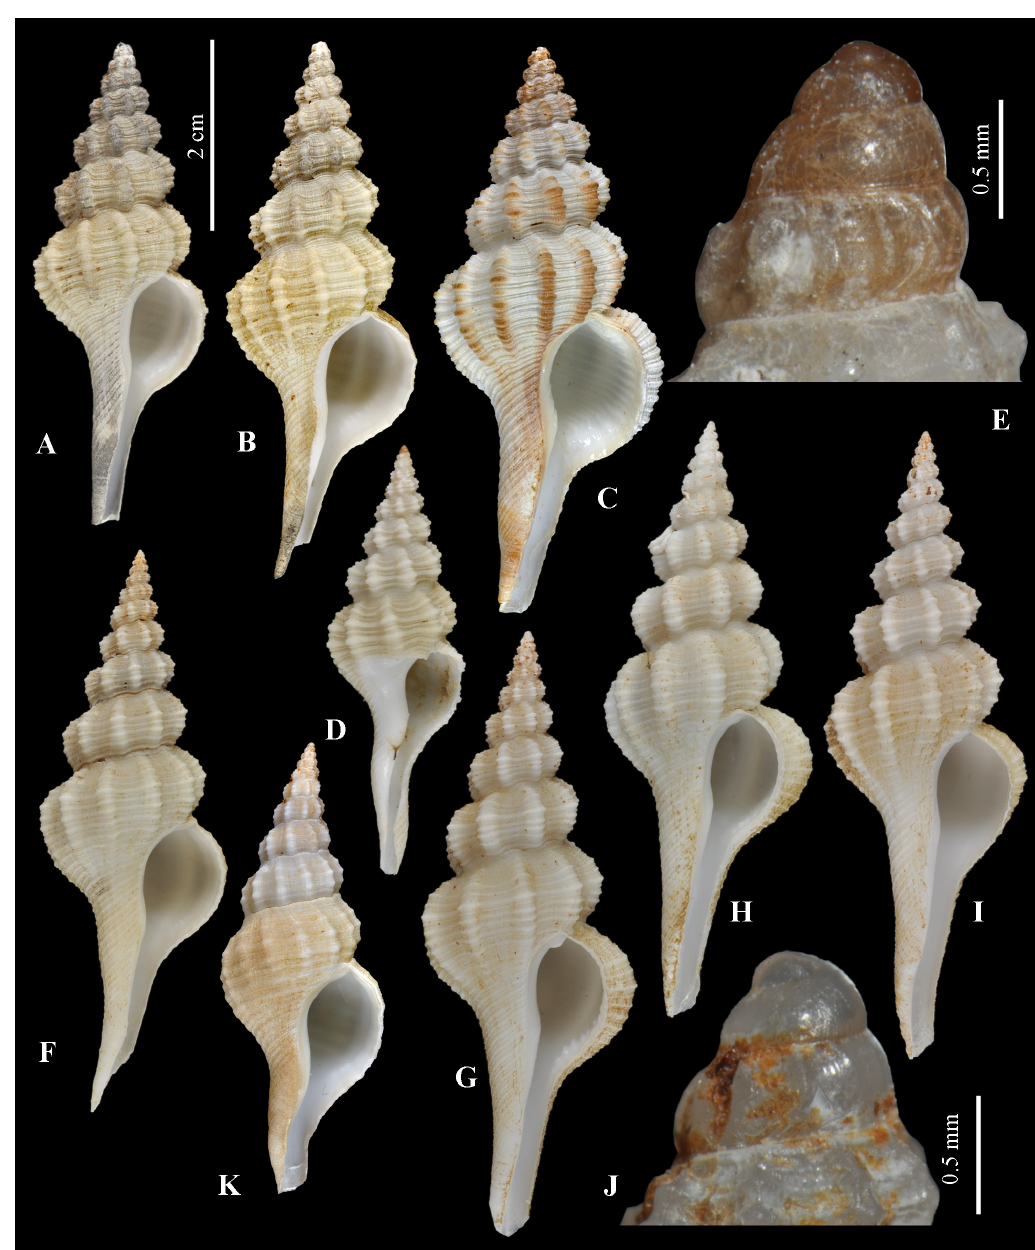
Fig. 11. Species of Vermeijius gen. nov. A–E . Vermeijius pallidus (Kuroda & Habe, 1961) gen.